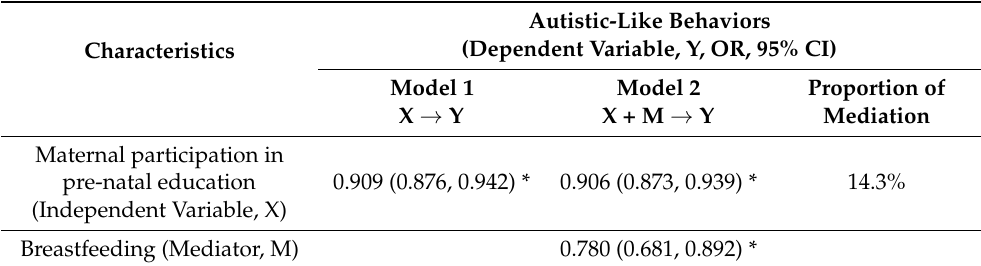
Table 7. Mediating effect of breastfeeding on association between maternal participation in prenatal education and autistic-like behaviors of preschoolers # .